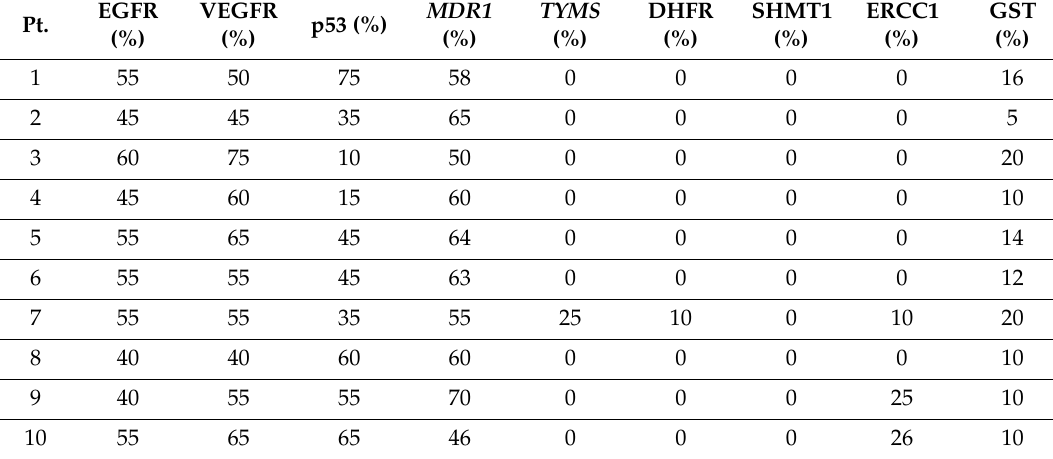
Table 3. Liquid biopsy CTC tumour gene expression assays.